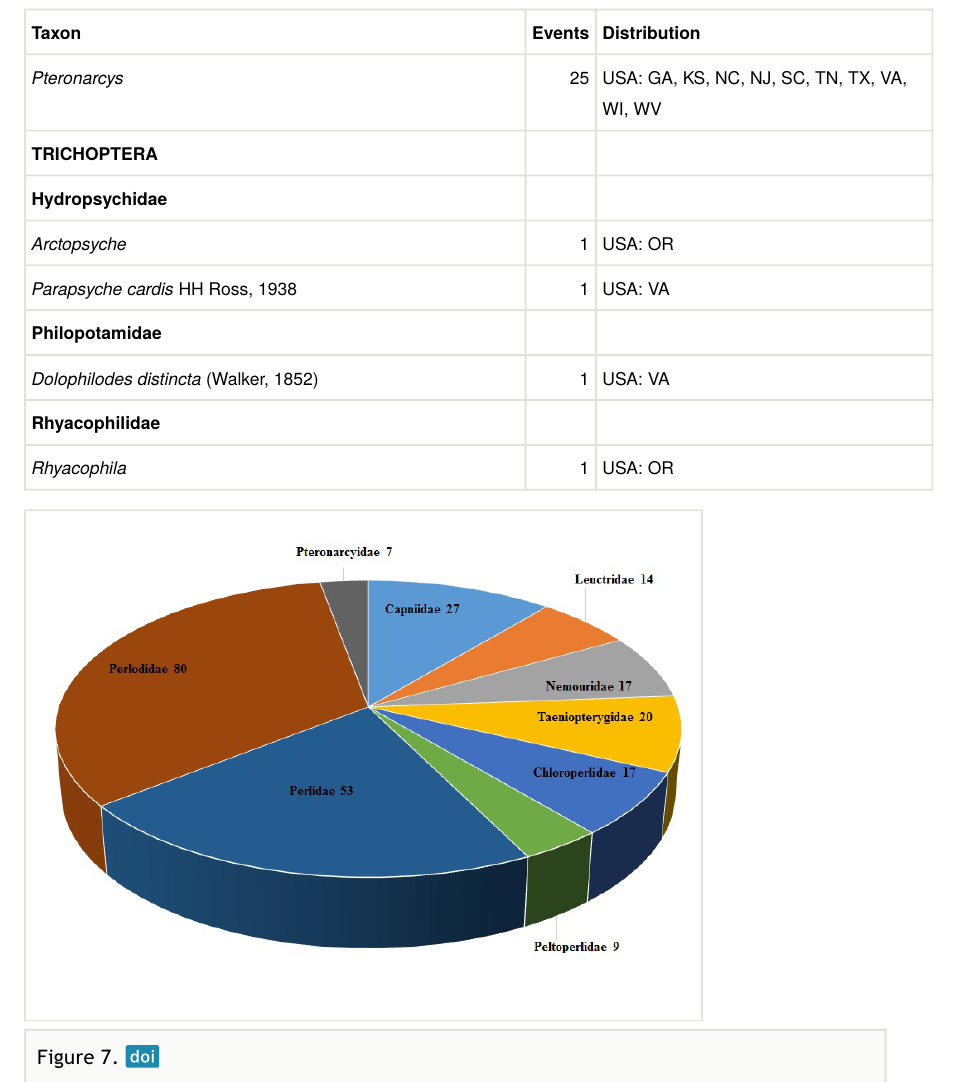
Number of stone fl y species by family present in the donated Plecoptera collections. The number to the right of the family name is the number of